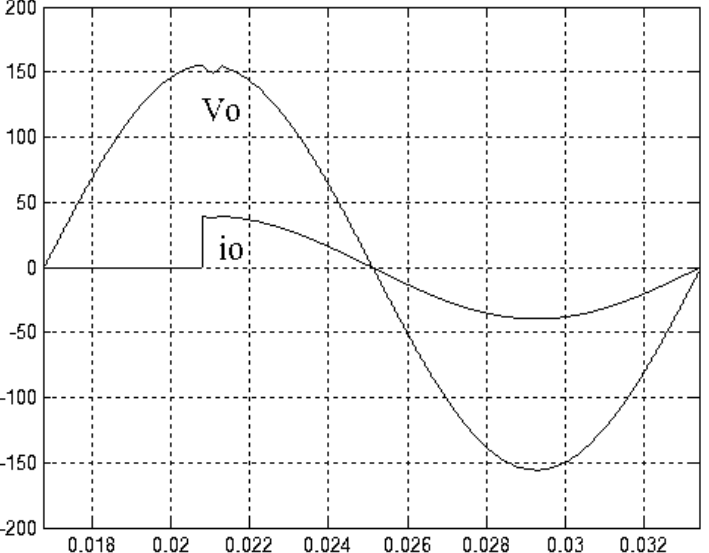
Figure 3. Simulated output waveforms at step-load changing conditions obtained using the proposed approach (Vo: output voltage; io: output current).